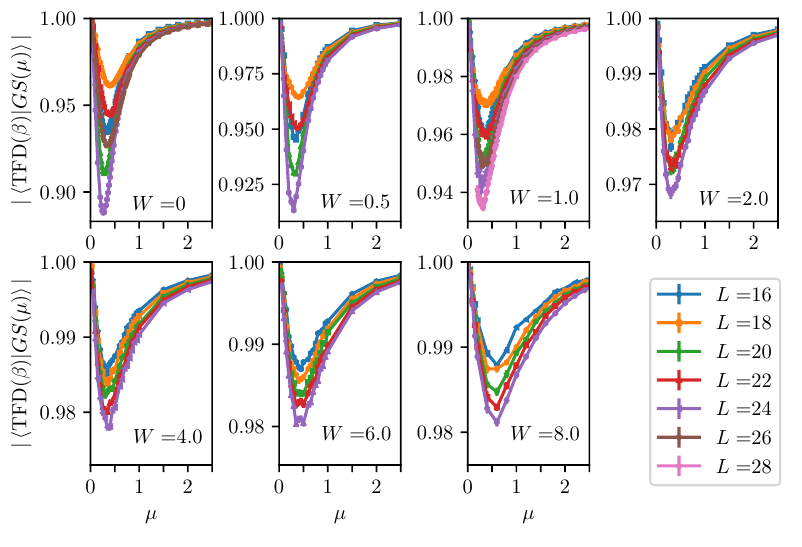
Figure 3 . Average overlap O = |h TFD( β ) | GS( µ ) i| at the optimal inverse temperature β = β ( µ ) as a function of coupling µ for the coupled spin chain model, for different strenghts of disorder W and sizes L . Results are averaged over more than 100 disorder